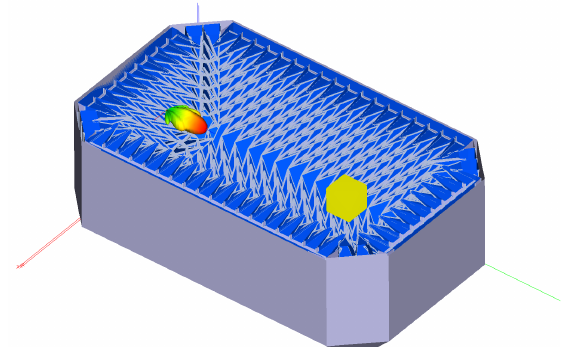
Figure 8. Simulation model used in Ansys Savant software for PO/UTD simulation (top part of the chamber removed for visualization